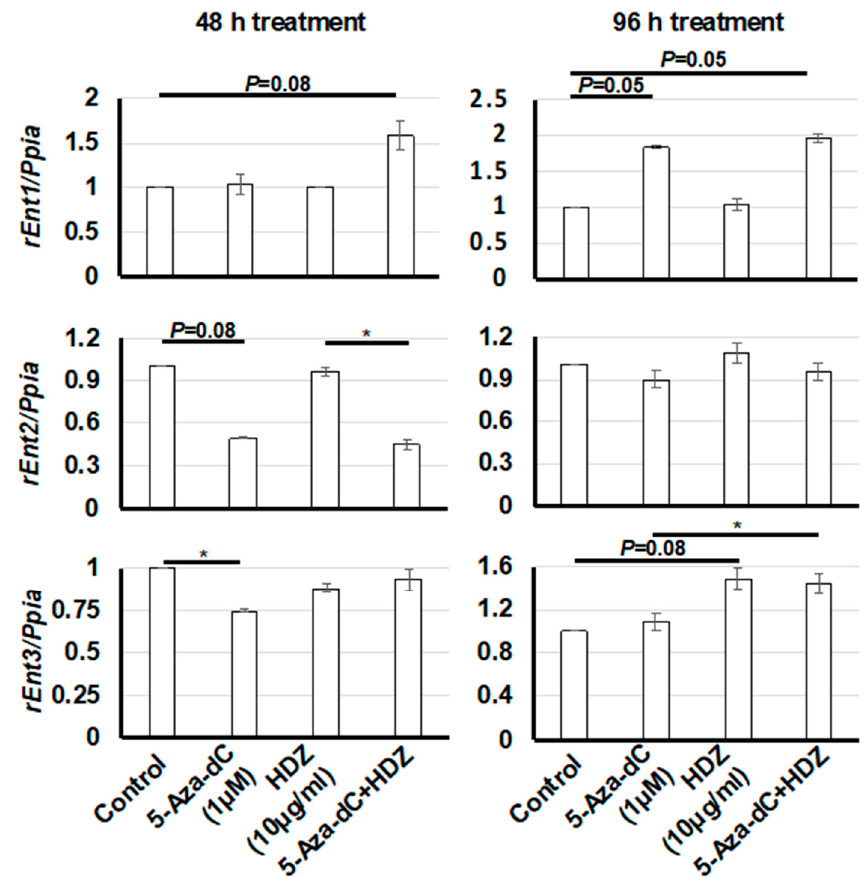
Figure 4. mRNA expression levels of rEnt1 , rEnt2 , and rEnt3 , which are rat equilibrative nucleoside transporter genes, in HSC-T6 cells treated with 5-aza-dC, HDZ, and 5-aza-dC and HDZ combined. The mRNA expression levels were measured by semi-quantitative RT–PCR. The effects of 5-aza-dC, HDZ, and combined treatment with 5-aza-dC and HDZ were compared with untreated control cells. Data are the mean ± SD (n = 3). * p < 0.05 vs. the untreated control.